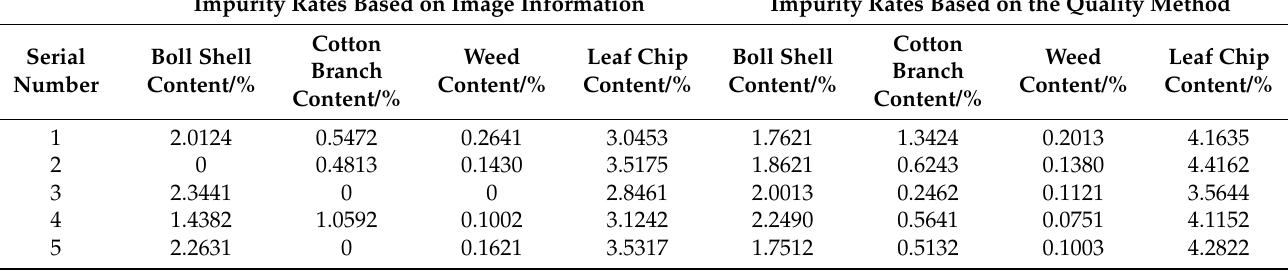
Table 4. The contents of various impurities in machine-picked seed cotton based on image information and quality